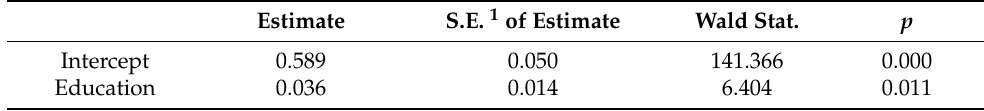
Table 5. Estimates of parameters—residents, biogas